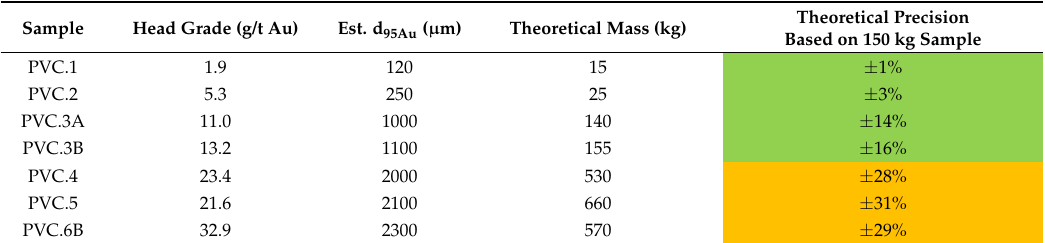
Table 23. Summary of sampling characteristics based on pilot plant